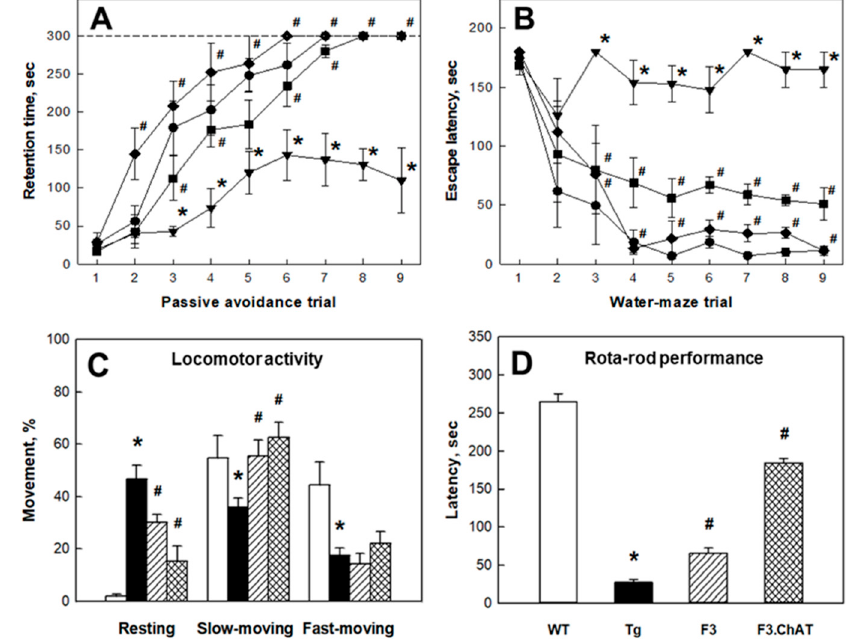
Figure 3. Cognitive function and physical activity of wild-type (WT) and APPswe/PS1dE9 transgenic (Tg) mice transplanted with F3 or F3.ChAT neural stem cells (NSCs). ( A , B ): Passive avoidance performance (A) and Morris water-maze performance (B). The endpoint was set to 300 s, if the animals failed to find the platform. ● : WT, ▼ : Tg, ■ : Tg + F3 NSCs, ♦ : Tg + F3.ChAT NSCs. ( C , D ): Locomotor activity (C) and rota-rod performance (D). White: WT, black: Tg, shaded: Tg + F3 NSCs, checked: Tg + F3.ChAT NSCs. *Significantly different from WT mice ( p < 0.05). # Significantly different from Tg mice ( p < 0.05).